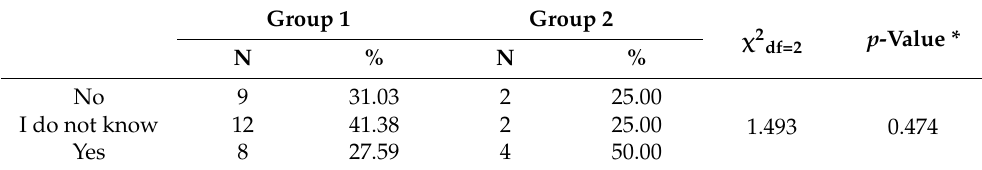
Table 4. Willingness to receive COVID-19 vaccine in the future among unvaccinated